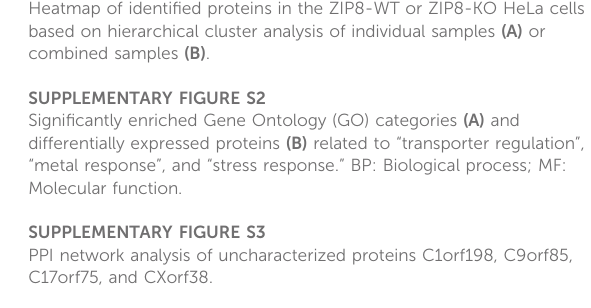
SUPPLEMENTARY TABLE S1 Data of iTRAQ-coupled LC-MS/MS analysis. SUPPLEMENTARY TABLE S2 Data of gene ontology (biological process) enrichment analysis of differentially expressed proteins. SUPPLEMENTARY TABLE S3 Data of gene ontology (cellular component) enrichment analysis of differentially expressed proteins. SUPPLEMENTARY TABLE S4 Data of gene ontology (molecular function) enrichment analysis of differentially expressed proteins. SUPPLEMENTARY TABLE S5 Data of Kyoto encyclopedia of genes and genomes pathway enrichment analysis of differentially expressed proteins. SUPPLEMENTARY TABLE S6 Data of eukaryotic orthologous groups annotation analysis of differentially expressed proteins. SUPPLEMENTARY TABLE S7 Data of subcellular location of differentially expressed proteins. SUPPLEMENTARY FIGURE S1 Heatmap of identi fi ed proteins in the ZIP8-WT or ZIP8-KO HeLa cells based on hierarchical cluster analysis of individual samples (A) or combined samples (B) . SUPPLEMENTARY FIGURE S2 Signi fi cantly enriched Gene Ontology (GO) categories (A) and differentially expressed proteins (B) related to “ transporter regulation ” , “ metal response ” , and “ stress response. ” BP: Biological process; MF: Molecular